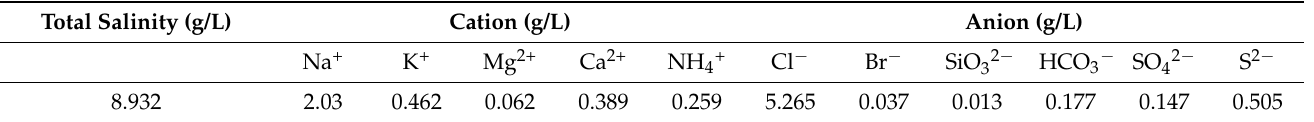
Table 2. Composition of formation water.